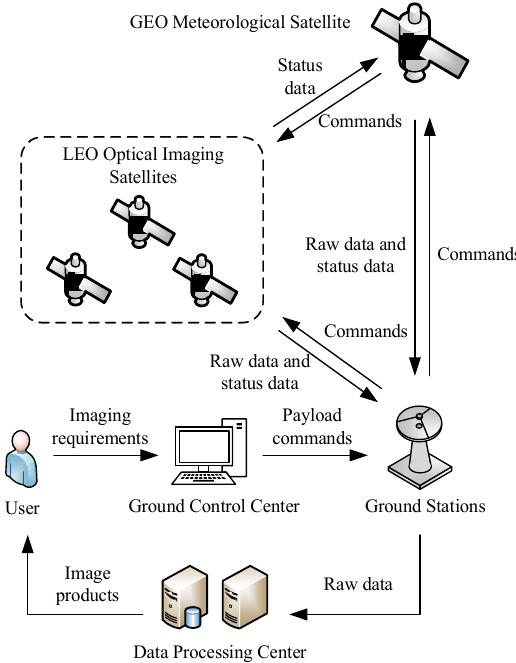
Figure 2. Operational workflow strategy of GEO–LEO satellites.